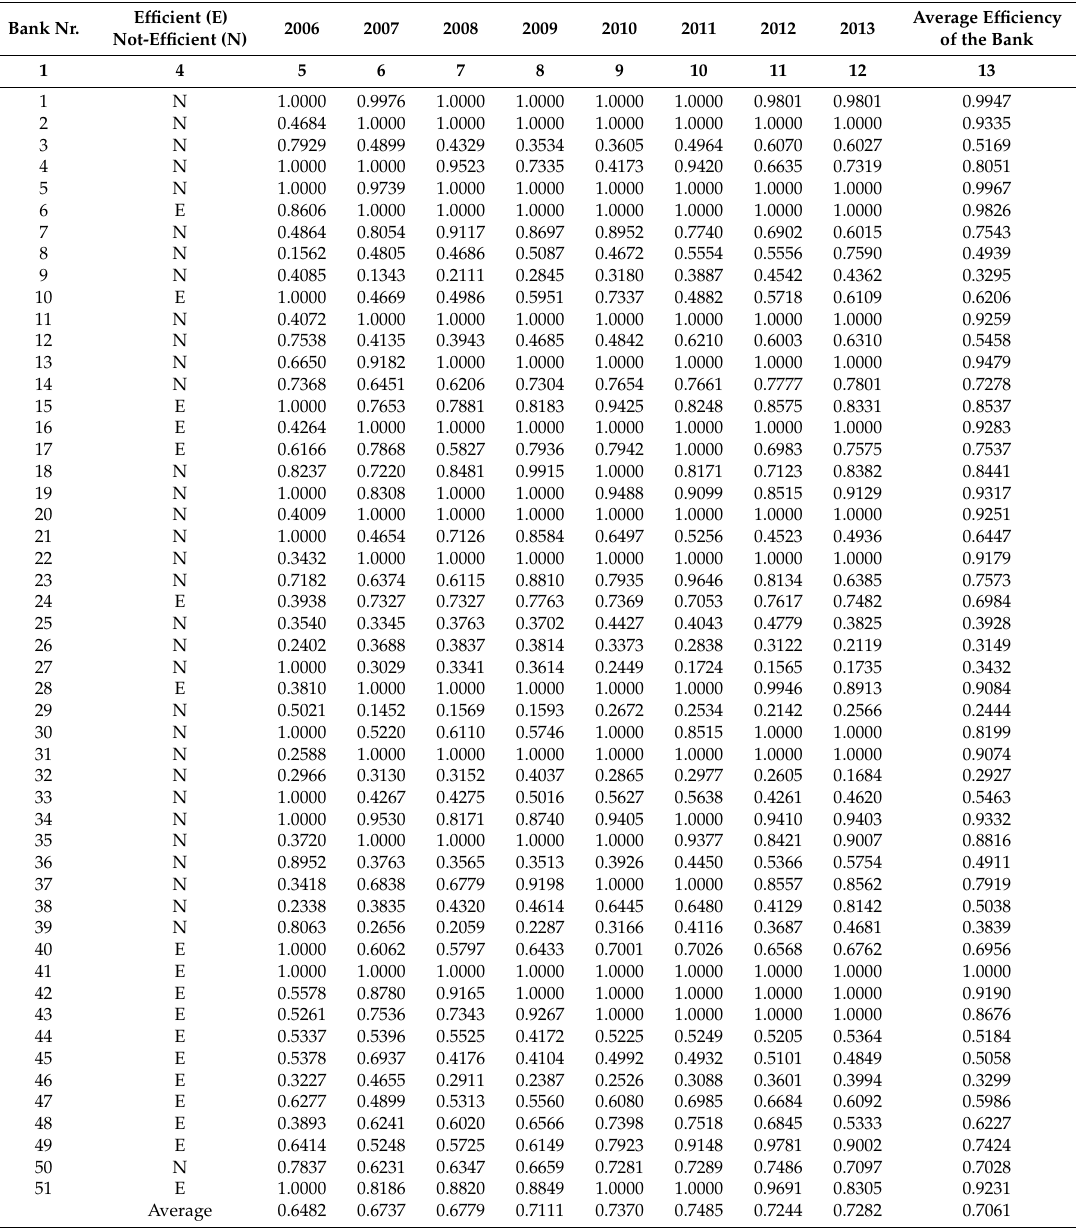
Table 6. Efficiency2 of individual banks (credits volume as the output). Bank